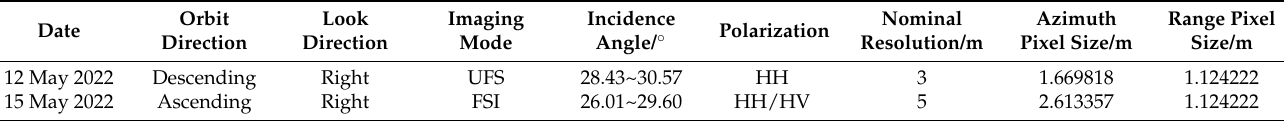
Table 2. Information of two C-SAR/01 satellite SLC images.